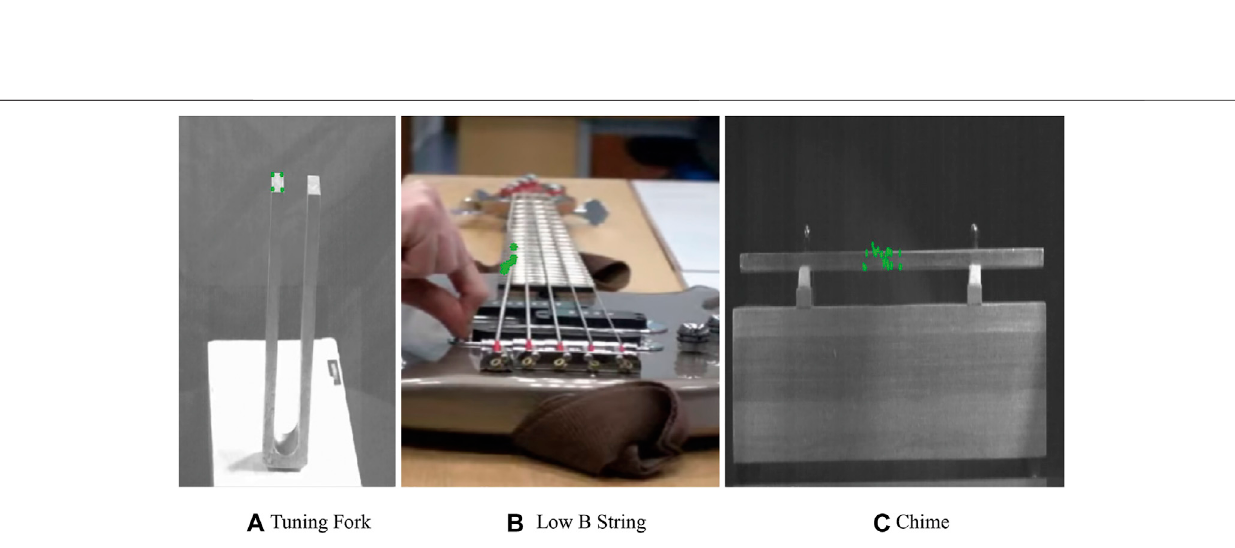
Frontiers in Energy Research | www.frontiersin.org February 2022 | Volume 10 | Article 764903